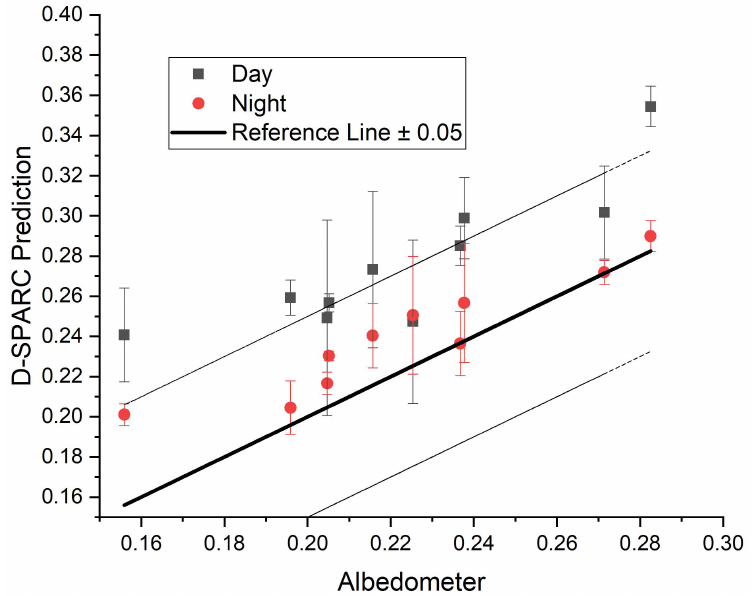
Figure 9. Measured and predicted albedos from the field